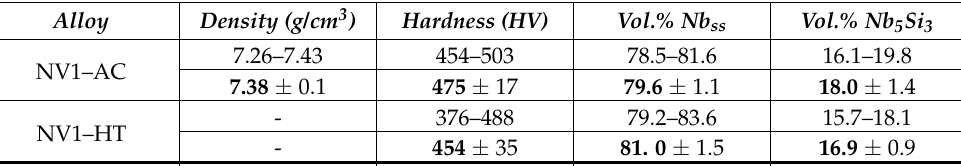
Table 1. Density, Vickers hardness, and vol.% of Nb ss and Nb 5 Si 3 . (Average values are shown in bold